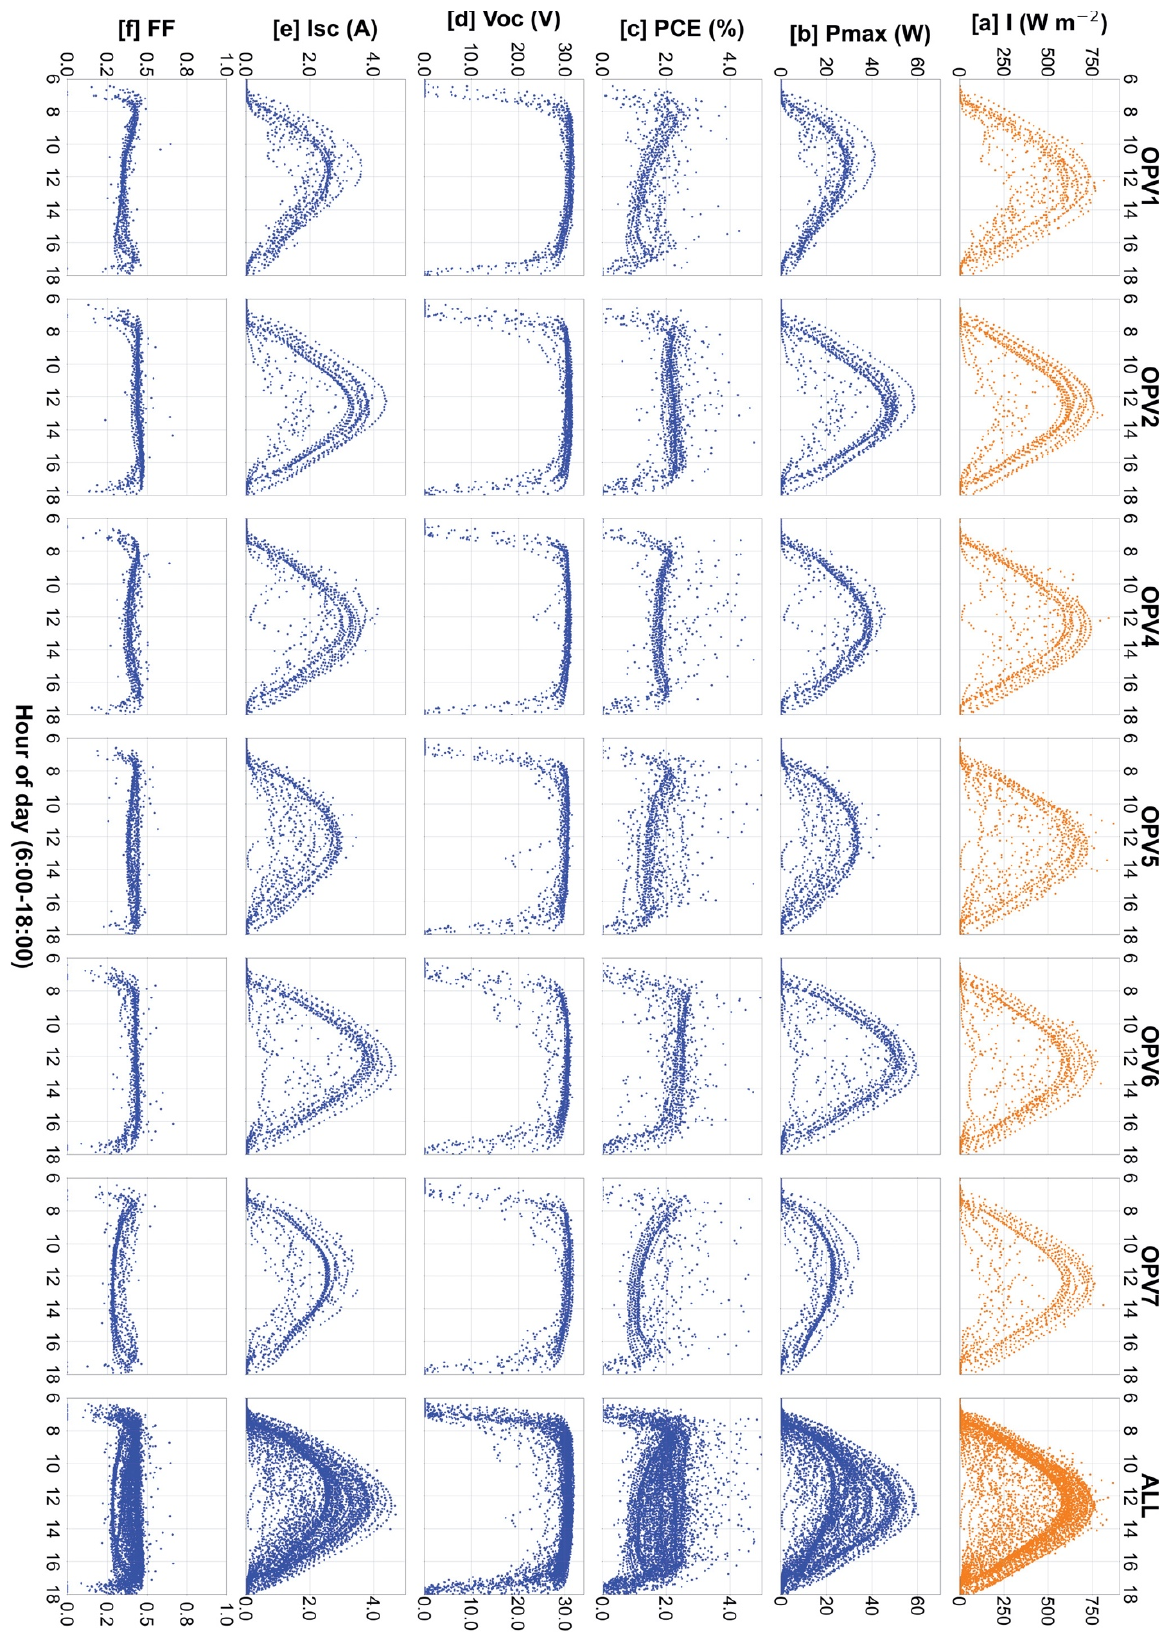
Figure 10. Diurnal OPV array performances between 28 October 2019–19 February 2020. Each point corresponds to a single I-V curve measurement of the connected OPV roll.